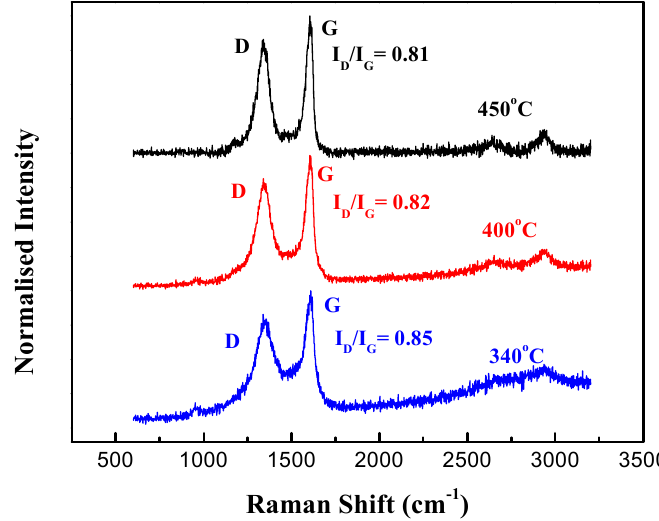
◦ C, 400 ◦ C and 340 ◦